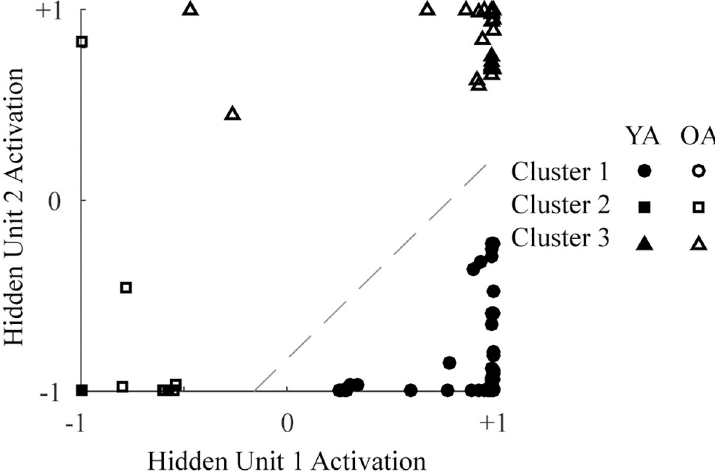
Fig 3. Activations within the hidden layer to each individual’s input data. The dashed line shows the decision boundary of the output unit. Filled markers represent younger adults (YA). Open markers represent older adults (OA). Marker shape (circle, square, or triangle) indicates cluster assignment as determined by k-means.